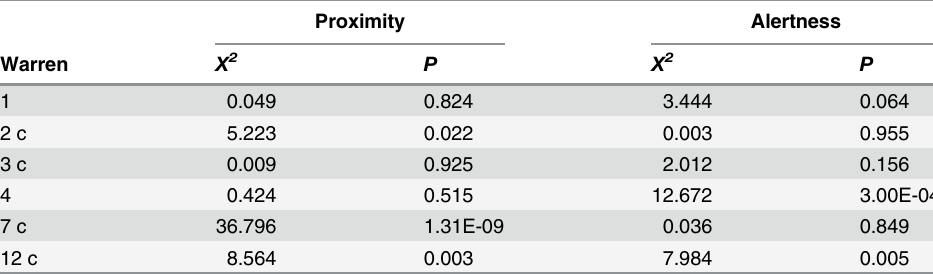
Table 1. Camera effect over mara behavior. Proximity